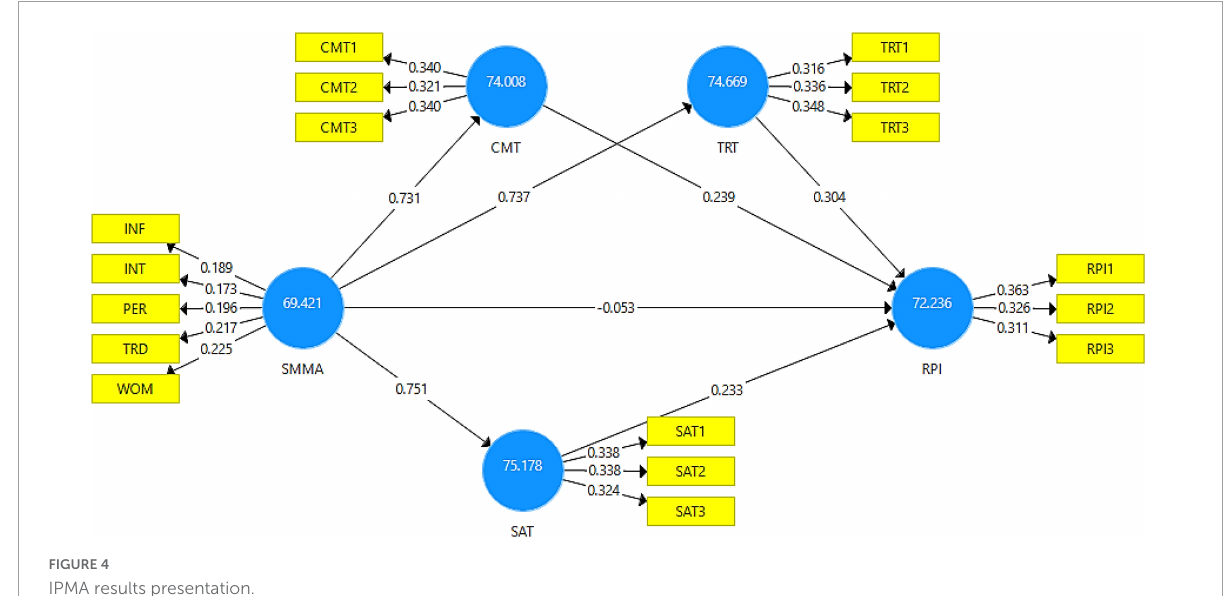
FIGURE4 IPMA results presentation.